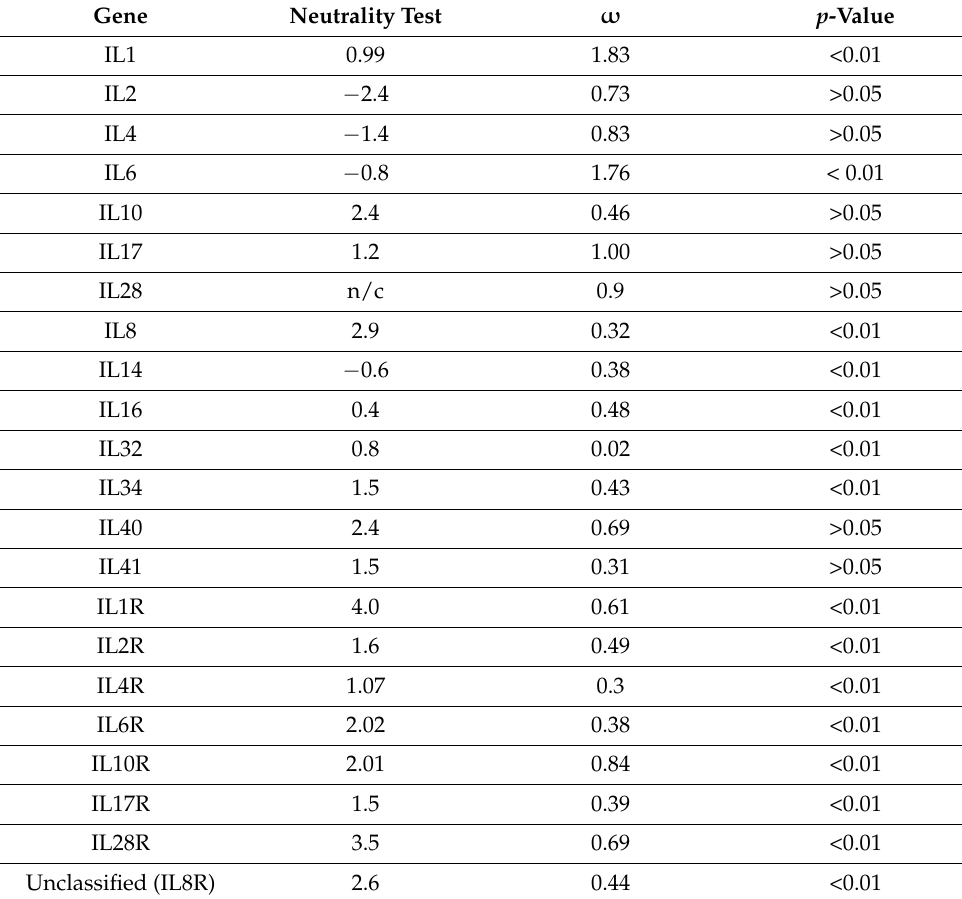
Table 2. Neutrality test and positive selection test ( ω ) for ILs and ILs receptors (for neutrality test, D is significant if >2 or < − 2).